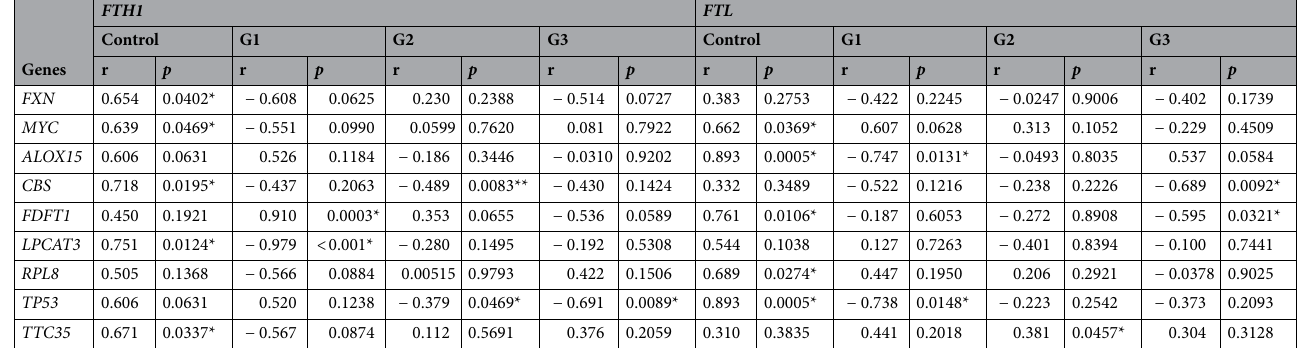
Table 2. Analysis of correlations of iron metabolism and ferroptosis genes with ferritin subunits, FTH1 and FTL . Correlation of iron metabolism and ferroptosis genes with ferritin subunits, FTH1 and FTL expression was determined by the Pearson correlation coefficient (r). Statistical significance is presented in table: * p <